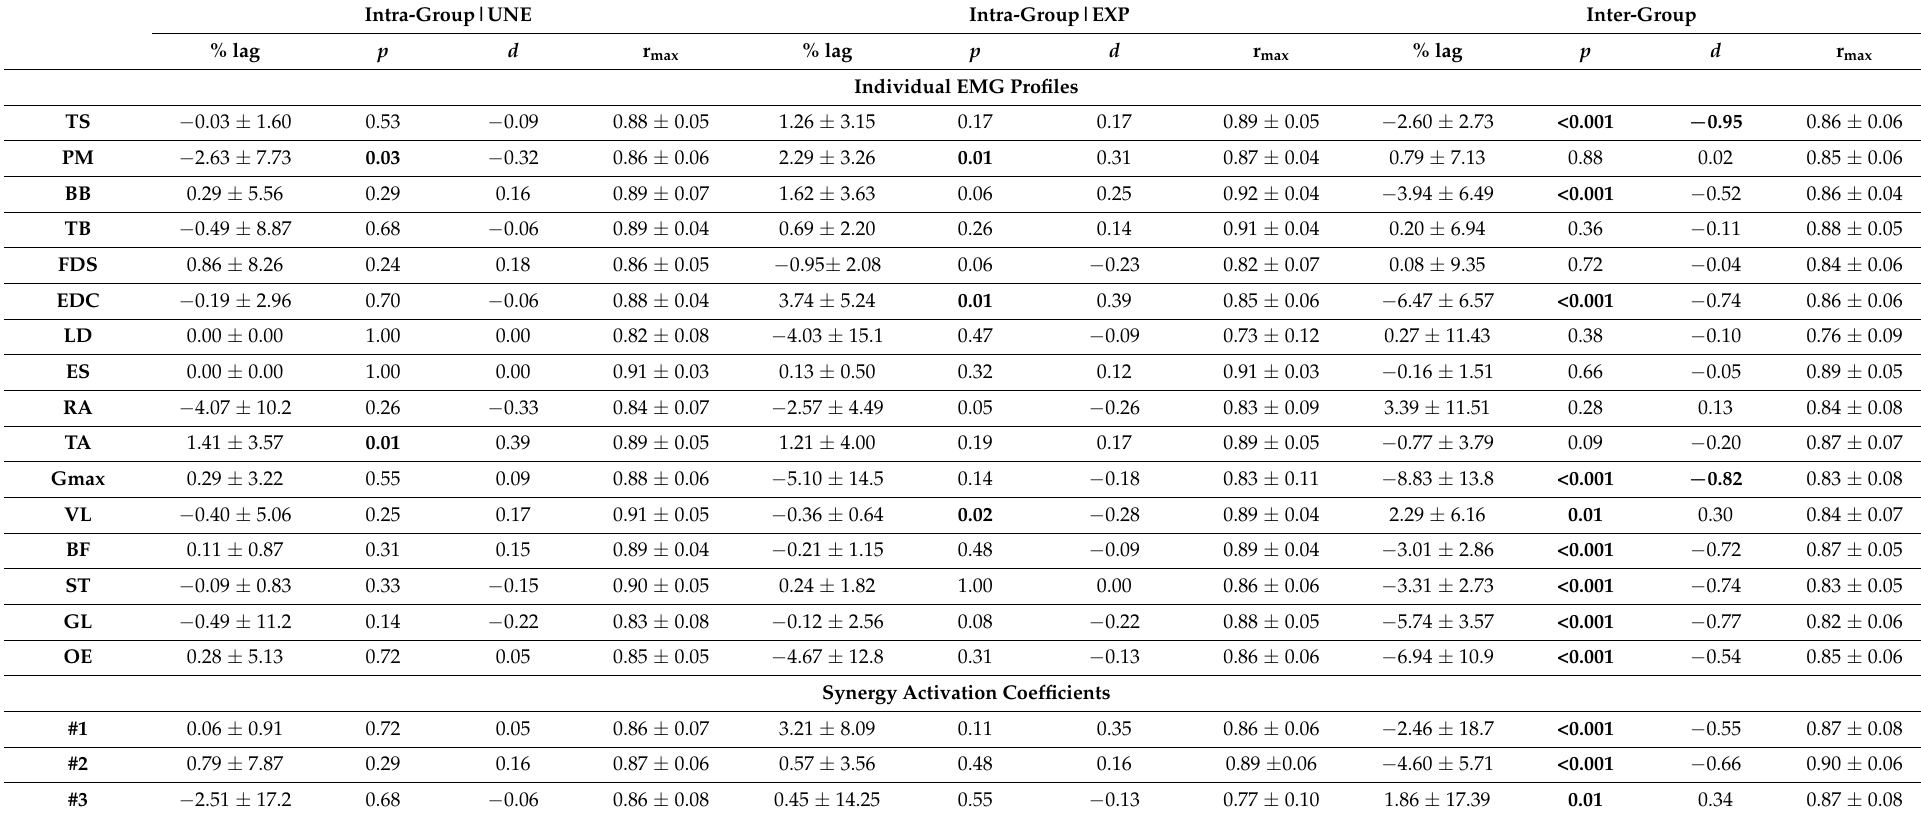
Table 2. Intra-group and inter-group similarity values (r max ) and lag times (%) of synergy activation coefficients and individual EMG profiles of weightlifters (EXP) unexperienced participants (UNE). Bold values represent statistical differences from zero and Cohen’s d above